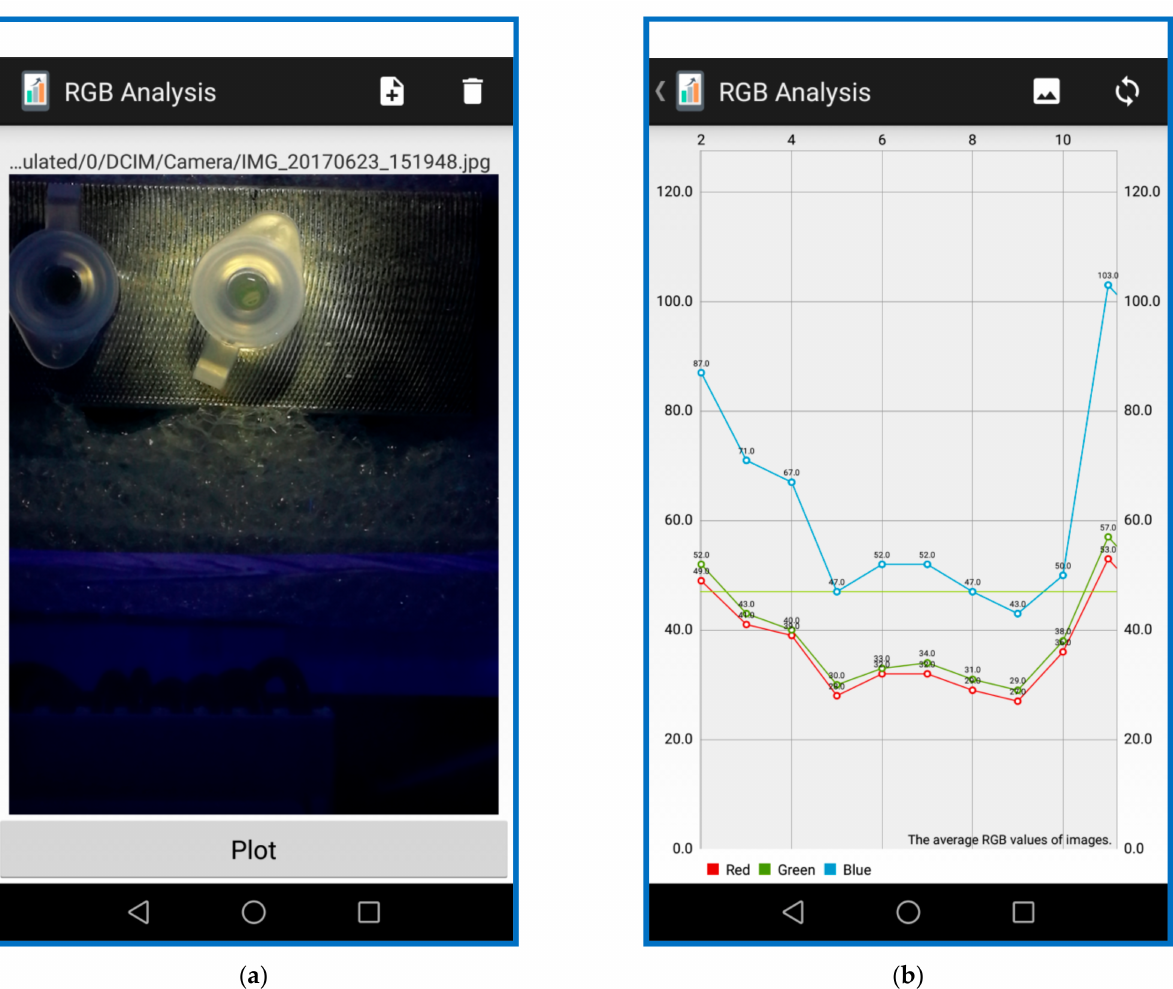
Figure 3. ( a ) Fluorescence image captured by the smartphone. ( b ) RGB intensity components for each